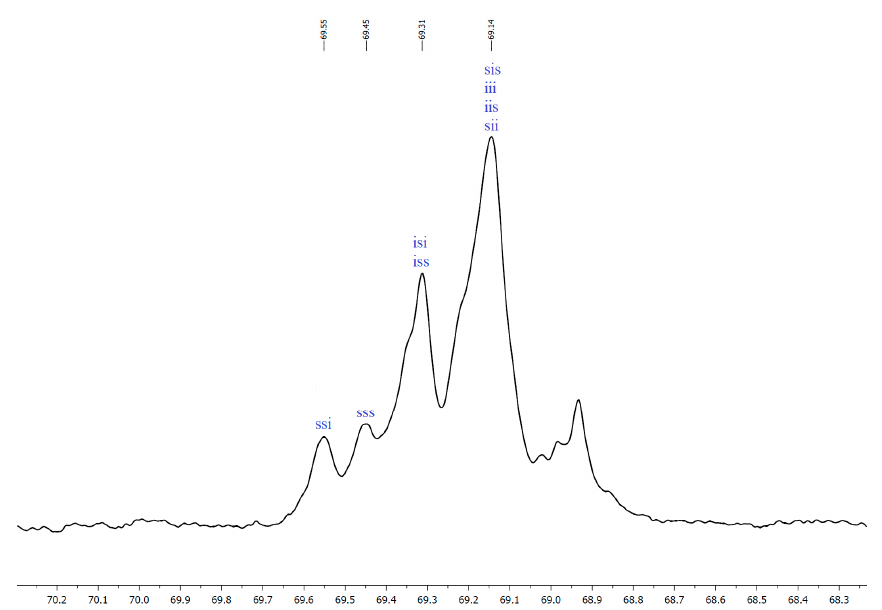
Figure 1. The 13 C NMR spectrum of rac (cid:31) lactide-poly(ethylene glycol) ( rac -LA-PEG) microstructure analysis (in CDCl 3 ).